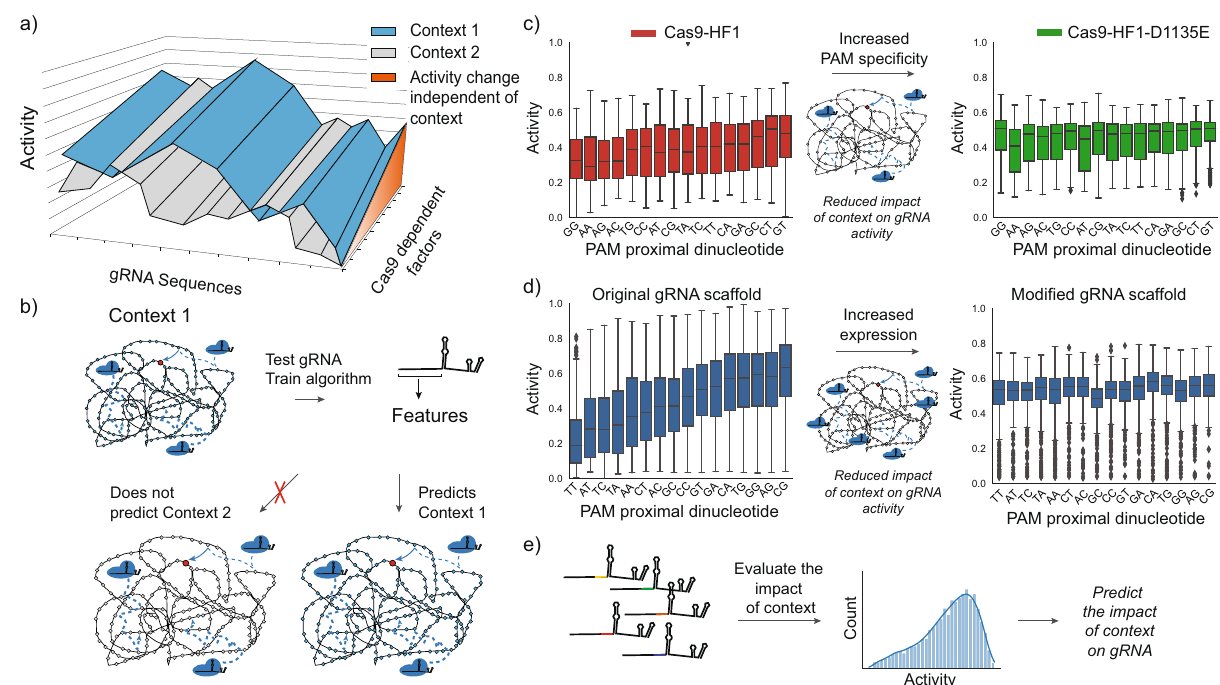
Fig. 8 Cas9/gRNA complex activity is highly dependent on genomic context. a A given gRNA can be expected to have different activity in different host organisms in a sequence speci fi c manner. Cas9 dependent factors that are independent of host context present an orthogonal axis of activity. b Therefore, current algorithms trained on gRNA sequence features can perform well within the same context but will not accurately predict other species. However, the impact of context on gRNA activity can be reduced through c increasing the speci fi city of Cas9 PAM binding to reduce potential interactions at non-target sites (data from Moreb et al. 2020, each boxplot represents n > = 209 gRNA) and d increasing the expression of Cas9 and/or gRNA (data from Kim et al. 2019 and Kim et al. 2020b on left and right, respectively. Each boxplot represents n > = 169 gRNA). e Understanding the PAM proximal impact of context on gRNA activity also allows targeted gRNA libraries to speci fi cally evaluate context effects (see Supplementary discussion on evaluating